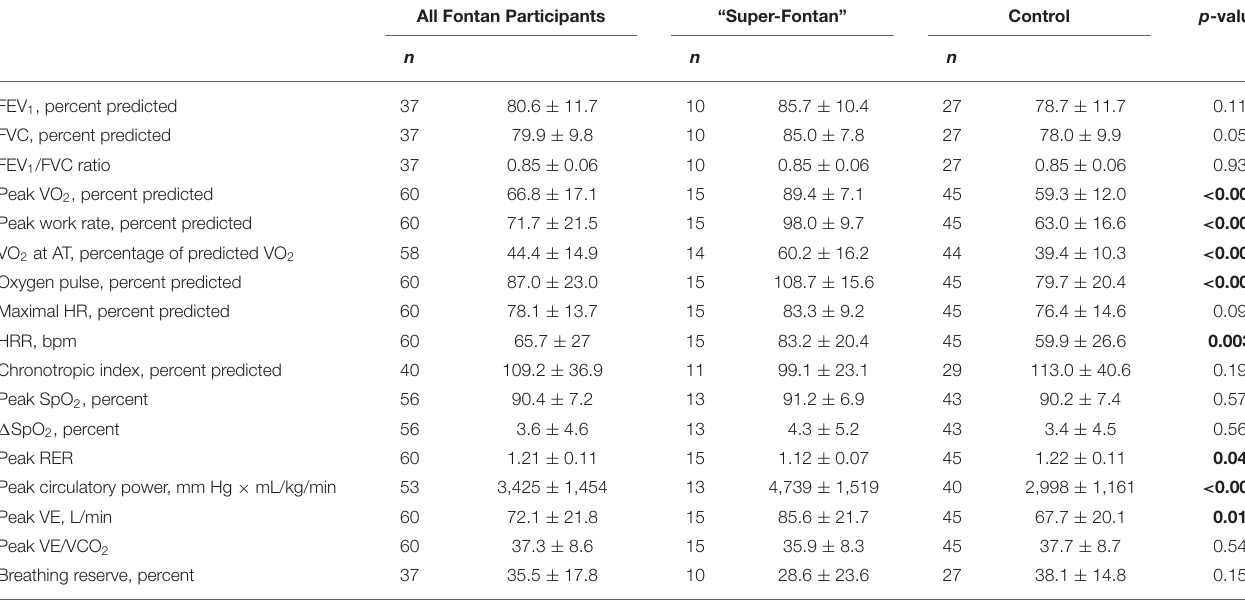
TABLE 2 | Lung function and cardiopulmonary exercise testing results.